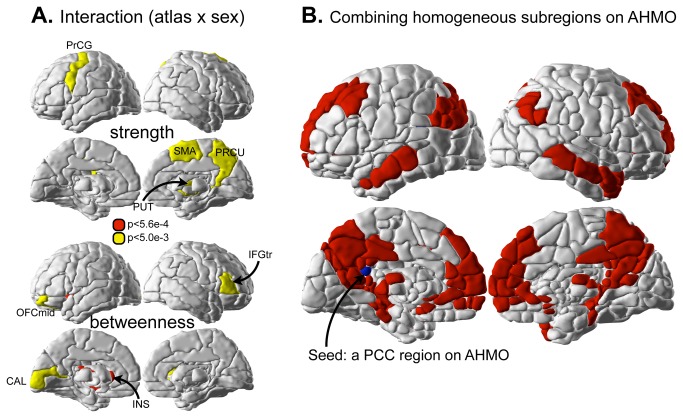
Sex-atlas interactions and functional connectivity maps from the posterior cingulate subregion.(A) Although we did not find any interaction effect in functional connectivity and in global properties (P>0.005), we found a tendency towards interaction between sex and atlas in nodal properties in some brain regions (P<0.005, uncorrected) and significant interactions at the left insula (p<0.05, Bonferroni corrected for all comparisons) in betweenness centrality. They include the left precentral gyrus (PrCG), right supplementary motor area (SMA), right precuneus (PRCU), and right putamen (PUT) in nodal strength and the left middle orbitofrontal cortex (OFCmid), the triangular part of right inferior frontal gyrus (IFGtr), left insula (INS), and left calcarine sulcus (CAL) in betweenness centrality. (B) Subregions that are temporally correlated with a subregion within the posterior cingulate cortex in the AHMO.